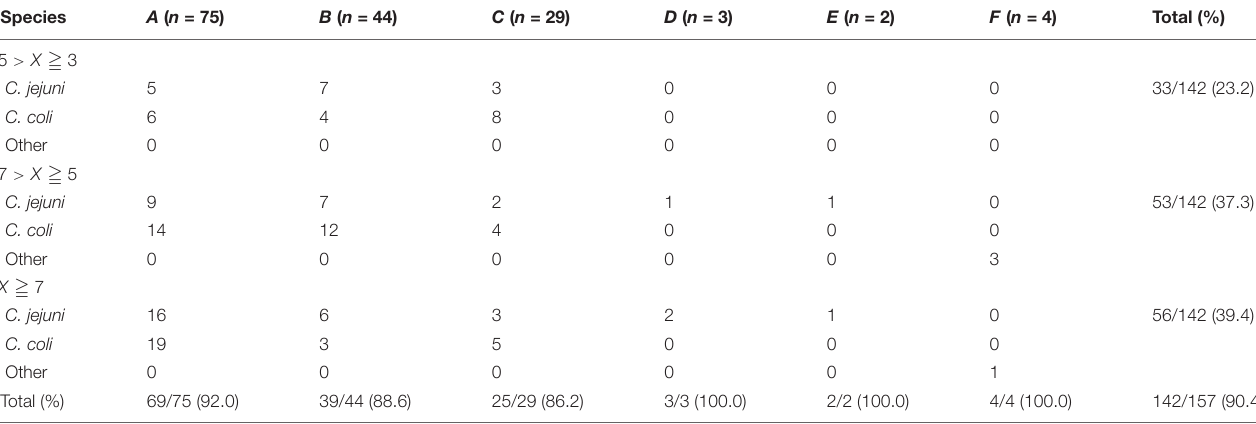
TABLE 2 | Multidrug-resistant (MDR) Campylobacter spp. isolates from different sources and species 1 . Species